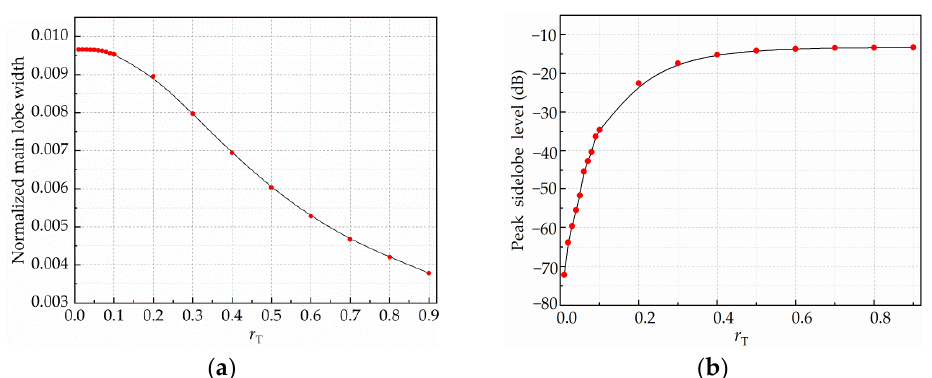
Figure 3. ( a ) Relationship between normalized main-lobe width and r T ; ( b ) relationship between peak sidelobe level and r T . peak sidelobe level and r T